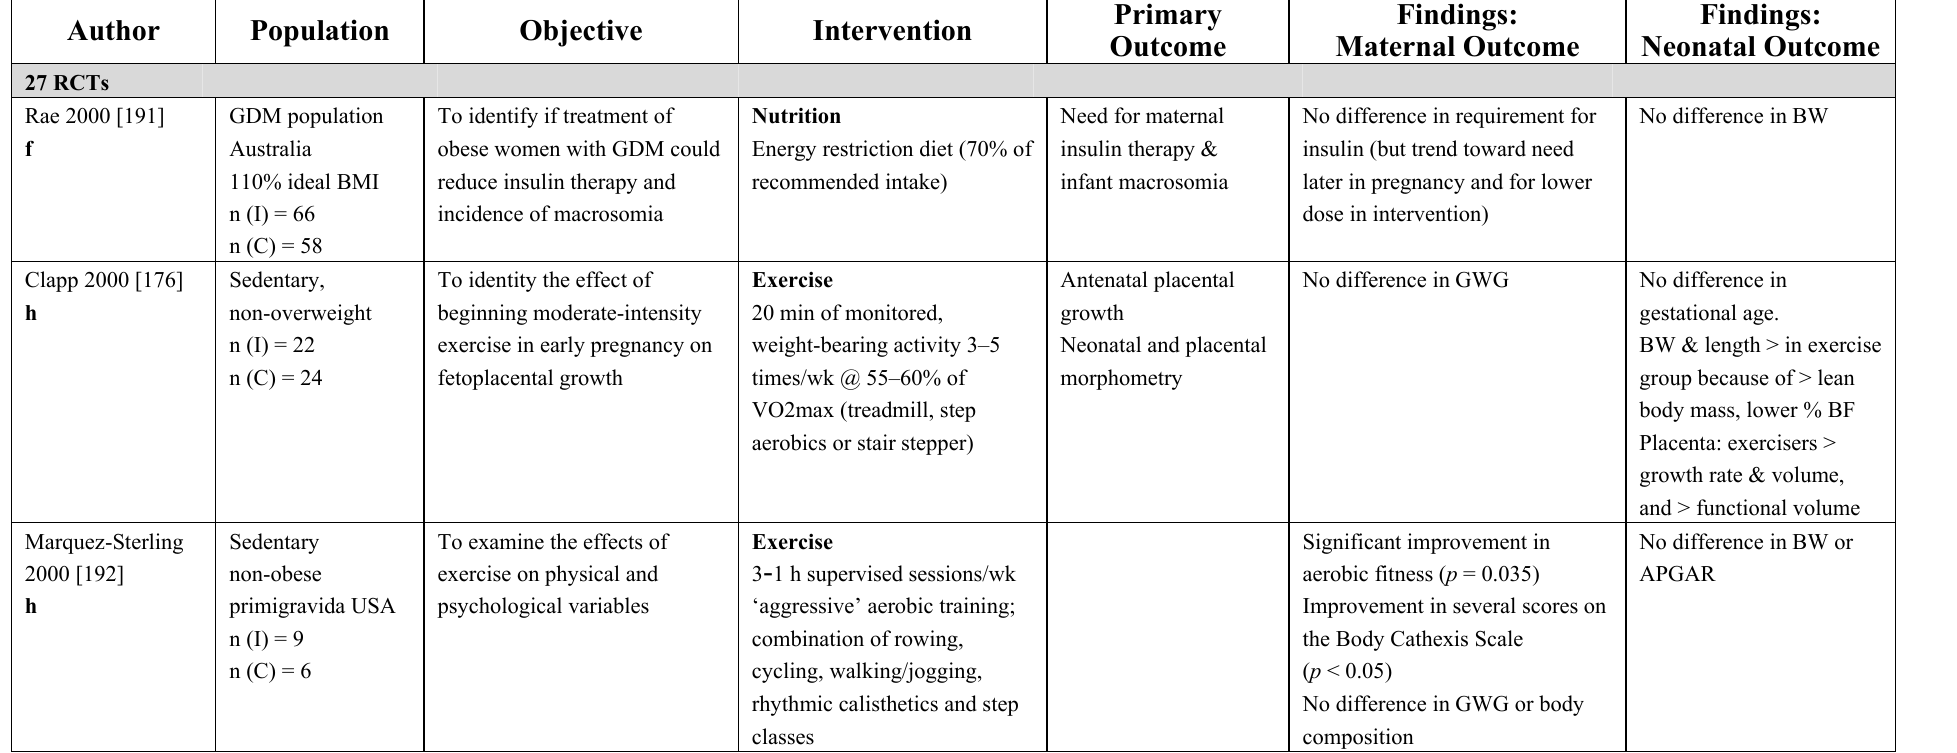
Table 1. Behaviour intervention trials targeting the gestational